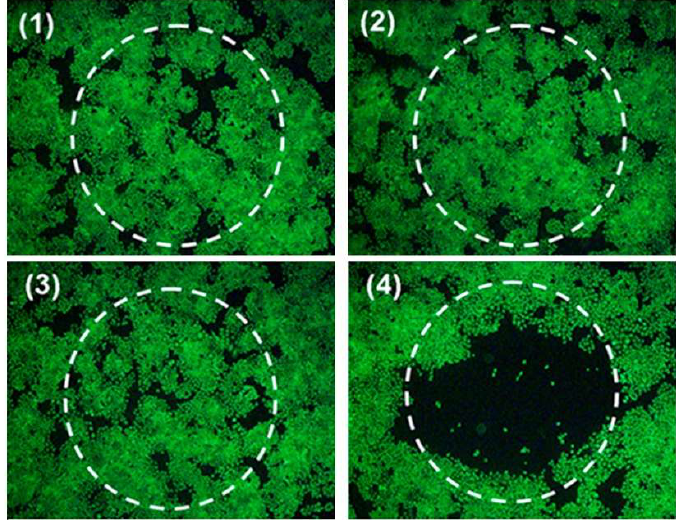
Figure 5. Adapted with permission from Ref. [64]. Photothermal destruction of Hela cells with or without Au@PB NPs and NIR laser (808 nm, 1.5 W∙cm −2 ) treatments.